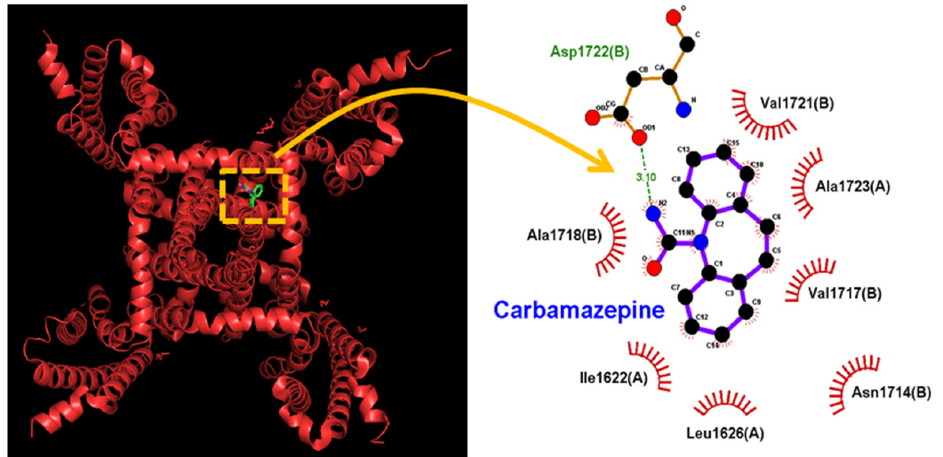
Figure 8. Docking results of hNa V 1.7 results and carbamazepine (CBZ). The protein structure of the hNa V 1.7 channel was obtained from PDB (PDB ID: 5EK0), while the chemical structure of CBZ was acquired from PubChem (Compound CID: 2554). The structure of the hNa V 1.7 channel was docked by the CBZ molecule through PyRx (http://pyrx.sourceforge.io/ accessed on 12 July 2022). The diagram of interaction between the hNa V channel and the CBZ molecule (at the right side) was generated by Lig- Plot + (http://www.ebi.ac.uk/thornton-srv/software/LIGPLOT/ accessed on 12 July 2022). Of note, the red arcs with spokes that radiate toward the ligand (i.e., carbamazepine, CBZ) indicate hydrophobic contact, while the green dashed line is the formation of hydrogen bond with a distance of 3.10 Å.